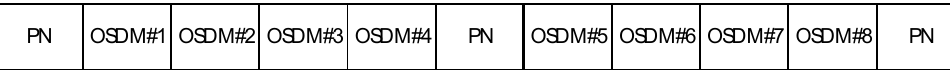
Figure 4. Data frame format of the UWAOSDM/PN.